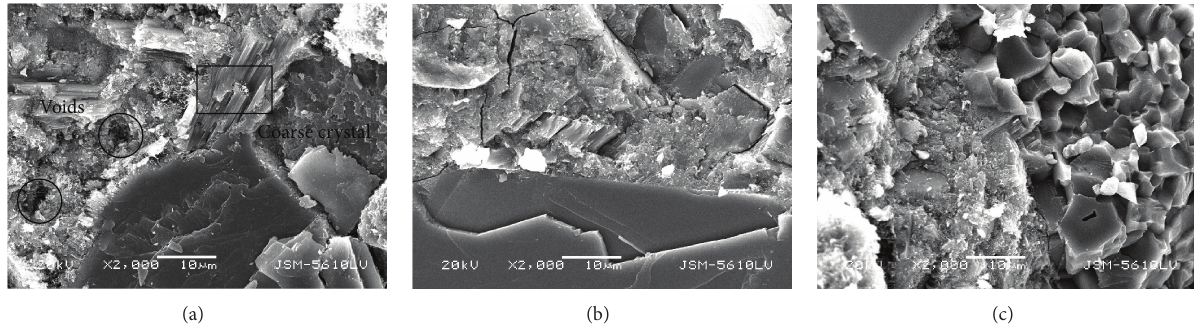
Figure 3: SEM images of ITZ in C30 CSC: (a) the control; (b) MB value 1.0; (c) MB value